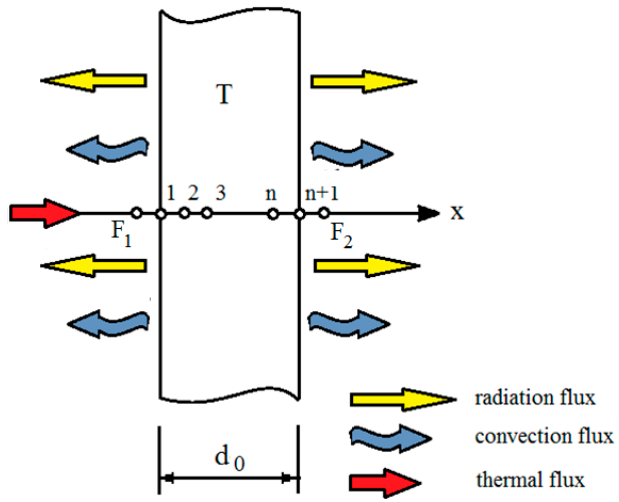
Figure 6. Scheme with finite differences.